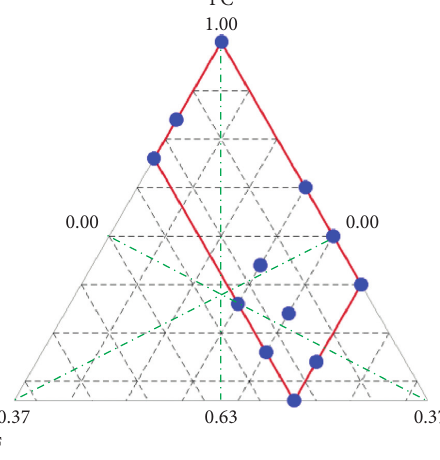
Figure 1: Spatial distribution of the SCMs for the concrete